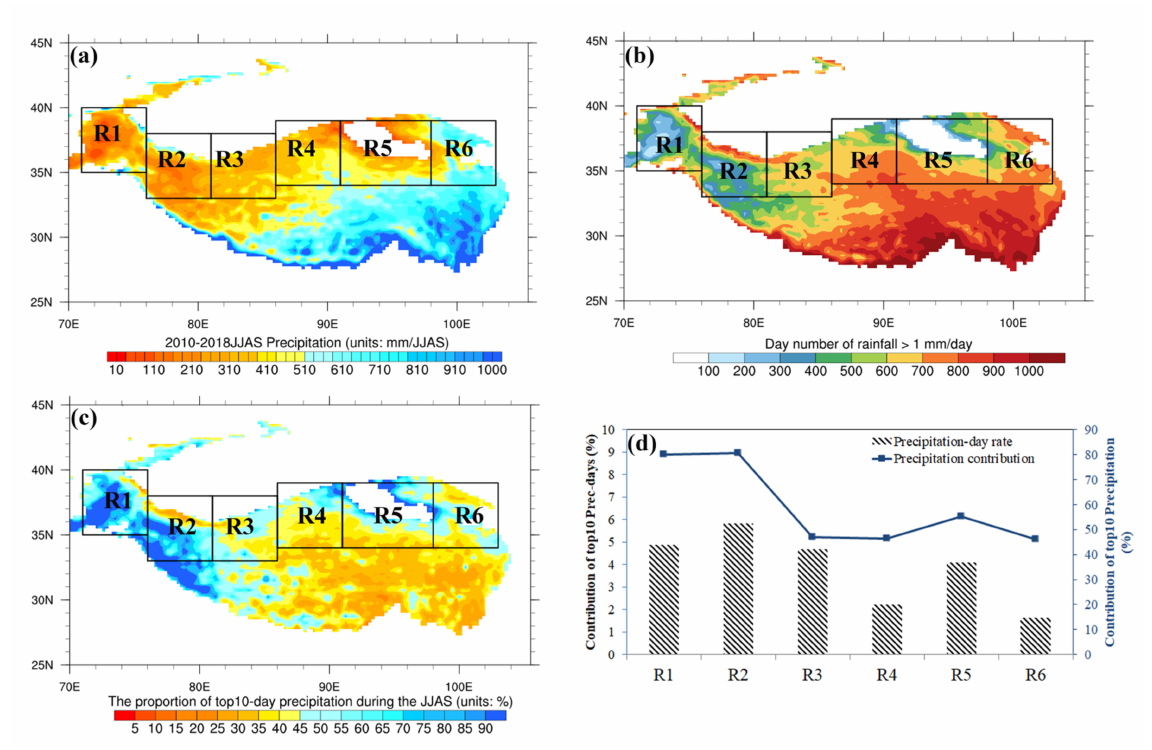
Figure 1. The distribution of precipitation features over the Northern Tibetan Plateau in the monsoon season (June-September or JJAS) from 2010 to 2018. ( a ) The mean JJSA precipitation averaged from 2010 to 2018 (unit: mm/JJAS), ( b ) the total day number of daily precipitation amount larger than 1 mm, from 2010 to 2018, ( c ) the ratio of precipitation amount in the strongest ten events to the precipitation during the monsoon-seasons (JJAS) (units: %), ( d ) the ratio of precipitation duration (precipitation amount) in the strongest ten events to that during JJAS (units: %). Note: from west to east, the target subregions were named as R1 (Lat: 35–40 ◦ N, Lon: 71–76 ◦ E), R2 (Lat: 33–38 ◦